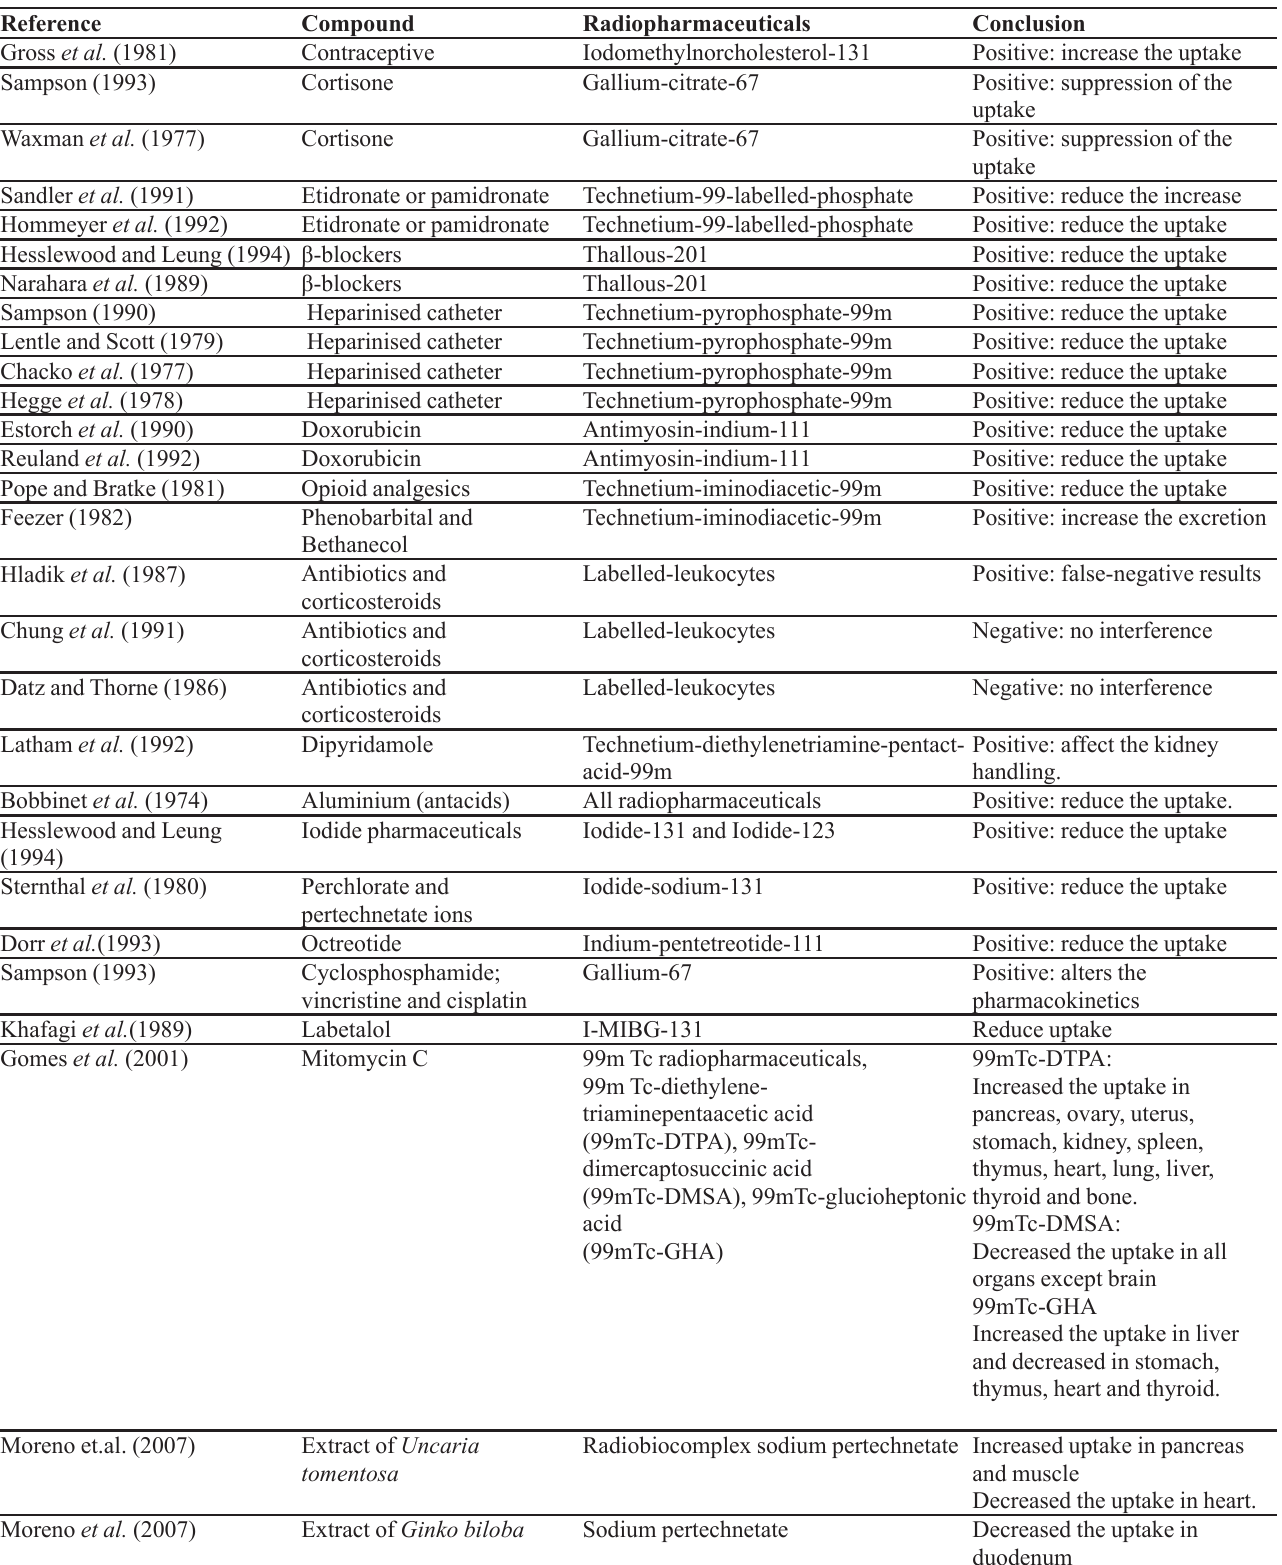
TABLE I – Summary of the compounds that might interfere with radiopharmaceuticals